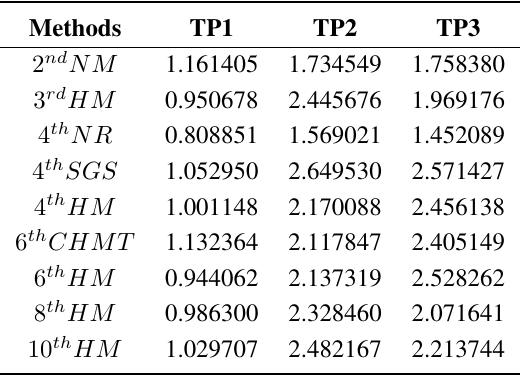
Table 2. Comparison of CPU time